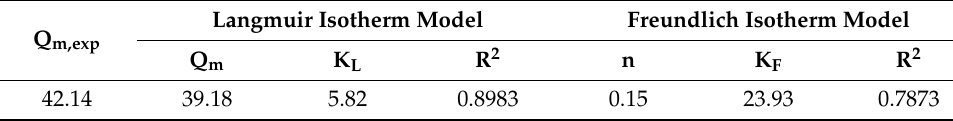
Table 3. Comparison of Q m for Cd 2+ using relevant adsorbents.